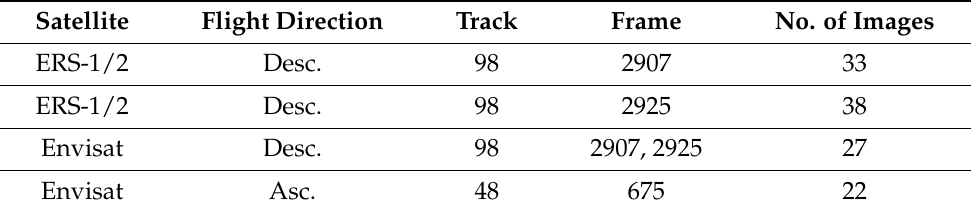
Table 1. Summary of the Synthetic Aperture Radar (SAR) data sets used in this